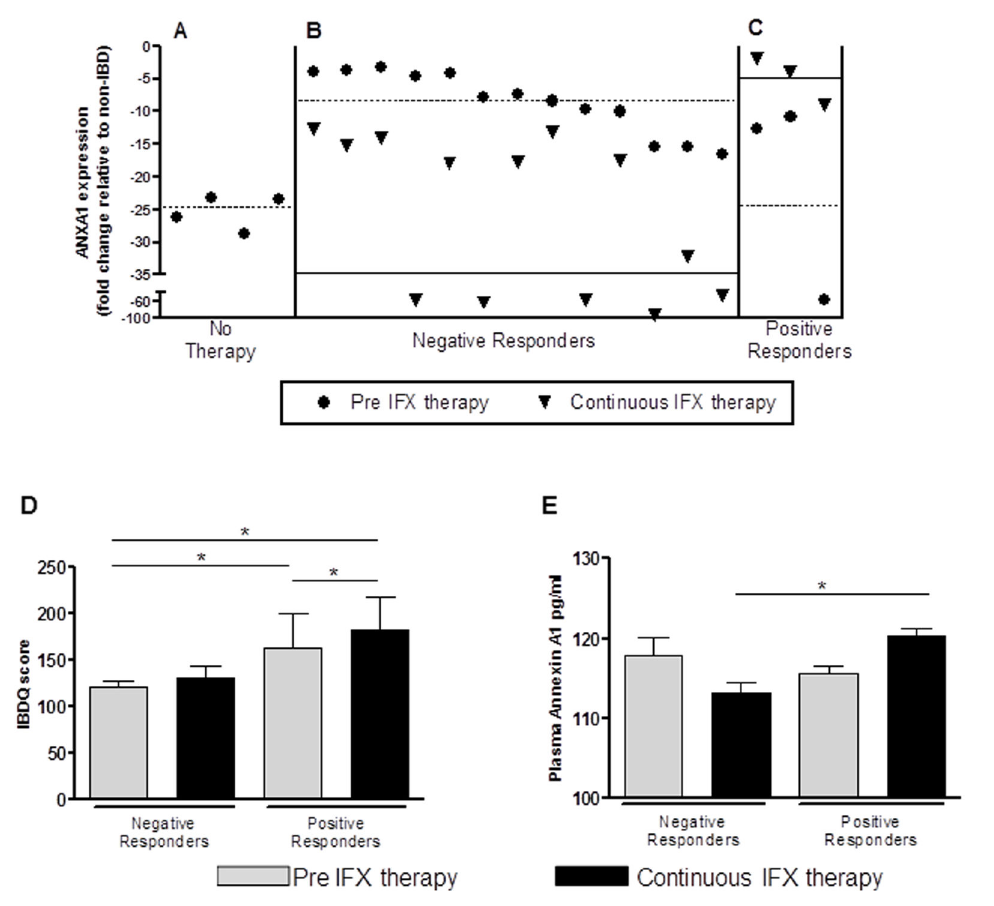
Figure 3. Analysis of longitudinal follow-up of IFX therapy influence on systemic ANXA1 expression. (A) IBD+ patients not on infliximab therapy; (B) IBD+ Patient group showing down-regulation of ANXA1 expression after continuous infliximab therapy; (C) Patient group showing up-regulation of ANXA1 expression after continuous infliximab therapy. The change in the transcriptional levels of ANXA1 between the 0 time point with no therapy and infliximab therapy showed 85% to be negative responders with a decrease in levels and 15% to be positive therapy responders with an increase in levels as compared to pre-therapy levels. The dashed lines are the mean of relative ANXA1 expression values at the first clinical attendance and the filled line are the mean ANXA1 levels following 3 months of infliximab treatment (longitudinal study of IBD patients n= 16). (D) Patients who were in the positive responder group had higher IBDQ scores as compared to those in the negative responder group both at baseline and following IFX therapy indicated a better clinical response in one group as compared to the other. Paired comparison of positive responders showed a significant increase in IBDQ score following continuous therapy. (E) Plasma Annexin levels were reflective of ANXA1 RNA levels in PBMCs. Similar trends were observed in the two patient groups as in PBMC. In positive responders there was an increase while in negative responders there was a decrease in plasma ANXA1 levels.(* p<.05). doi: